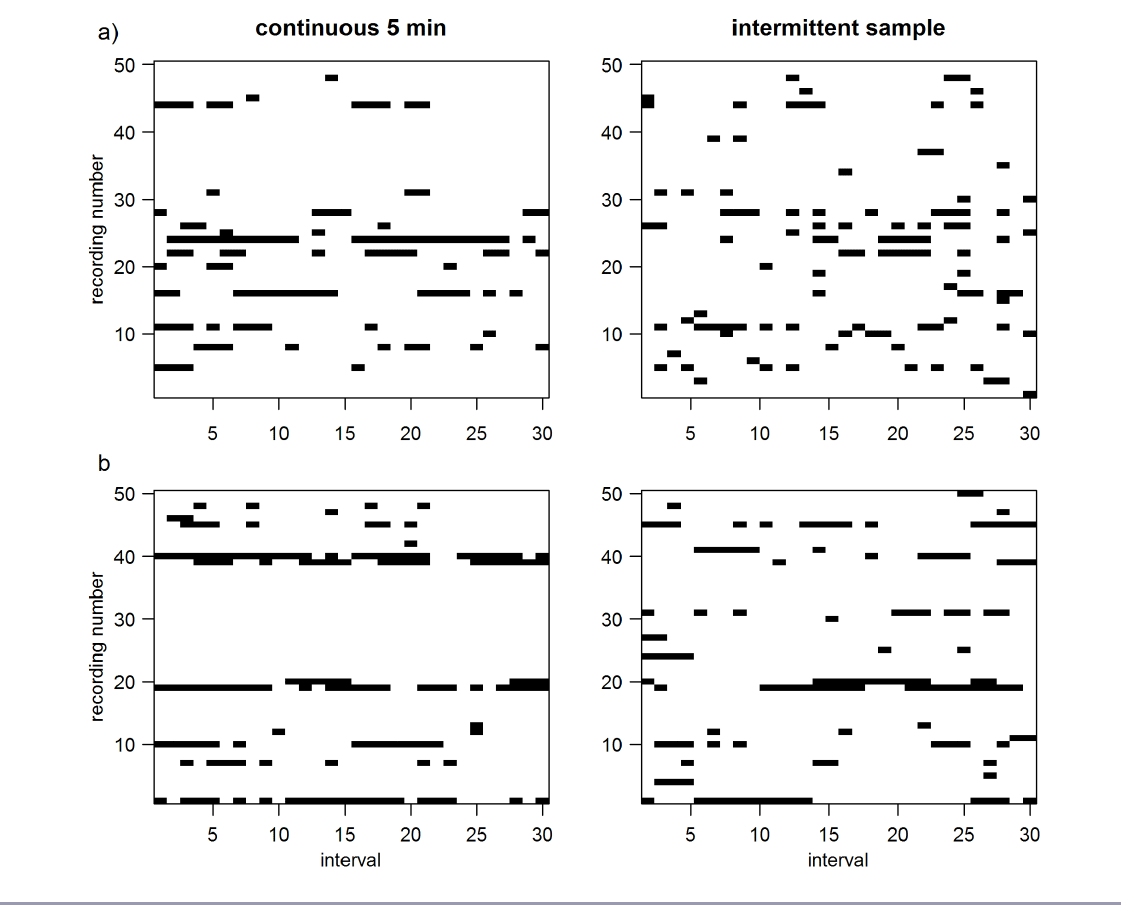
Fig. 3 . Example of the presence/absence data from two species (a) Silvereye ( Zosterops lateralis ), above and (b) Tomtit ( Petroica macrocephala ) below, collected by the two subsampling methods: continuous samples (left) and intermittent samples (right). Intervals along the x-axis are thirty 10-second subsamples with black shading indicating a recorded presence and white an absence, as illustrated in Figure 1. Fifty files (rows) were analyzed for each species using each method. Most species’ samples showed an increase in the number of short run lengths using the intermittent method, although the silvereye was the only species to exhibit a significant decrease in autocorrelation (lag = 1) between continuous and intermittent